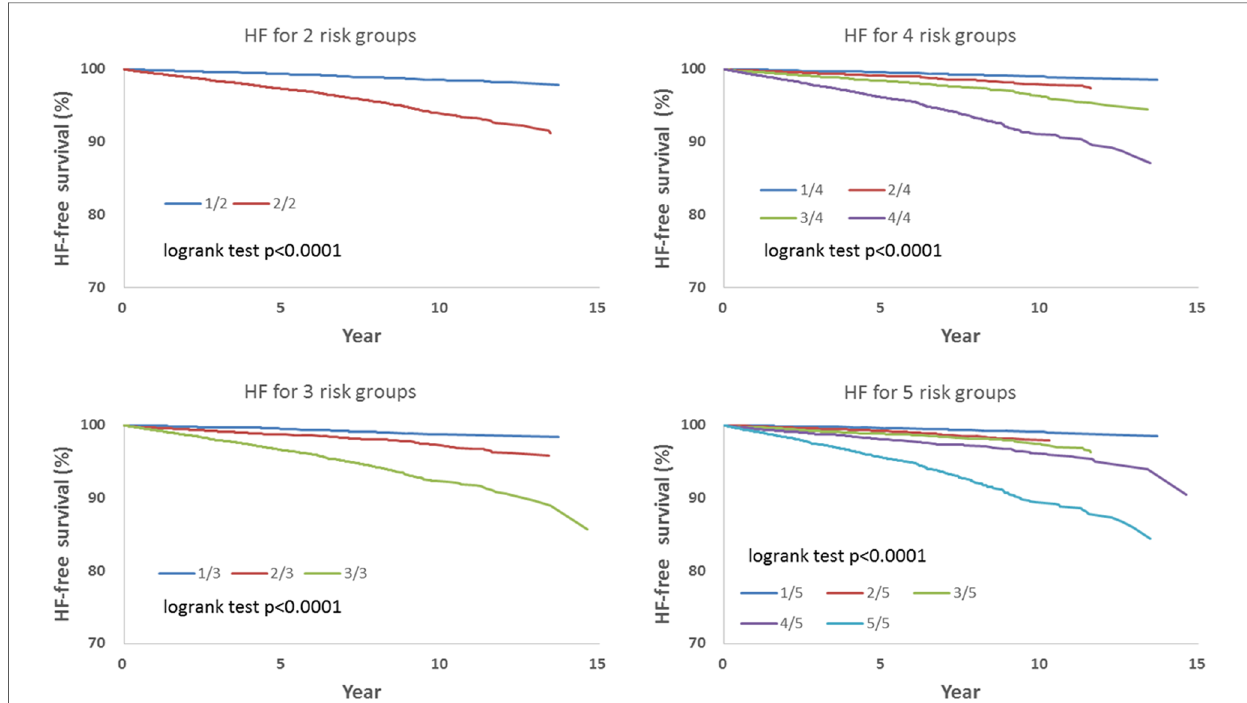
FIGURE 5 Based on Tables 2 , 3 , the hazard-based risk grouping effectively strati fi ed irradiated breast cancer patients in the endpoint of heart failure (HF; p <0.0001 in all